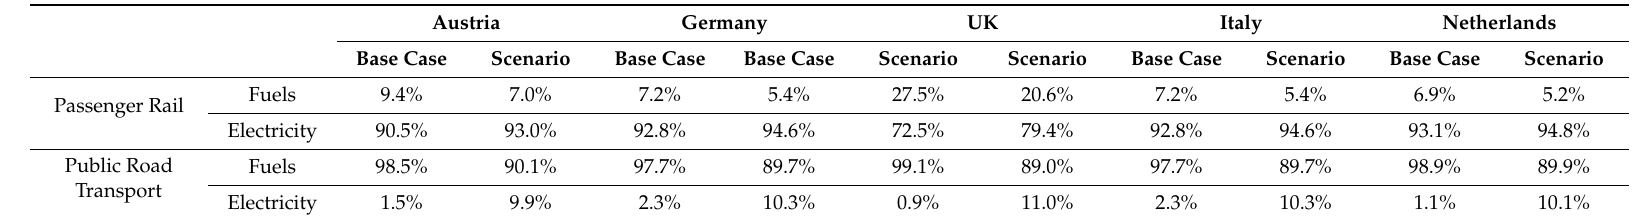
Table 3. Market shares of vehicle technology types in 2030.